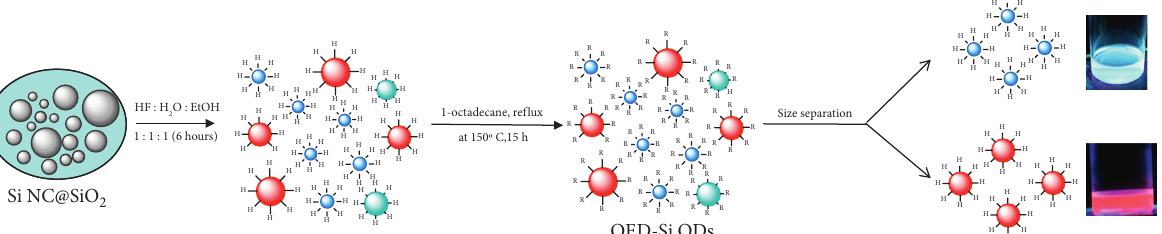
Scheme 3: Synthesis procedure of R-Si QDs and B-Si QDs.